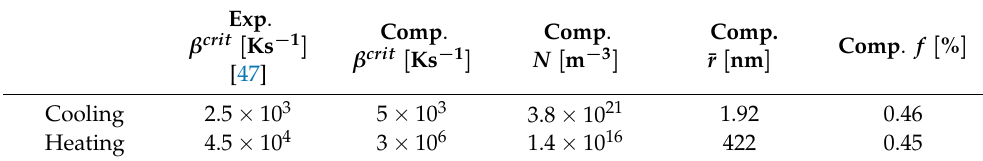
Table 2. The reported experimental and computed critical cooling β crit c and heating β crit well as the predicted associated residual particle density N , mean radius ¯ r and crystalline volume fraction f .